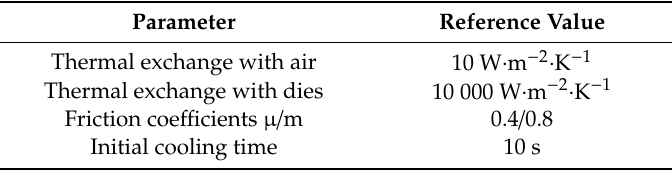
Table 3. Reference parameters of the FEM modelling of